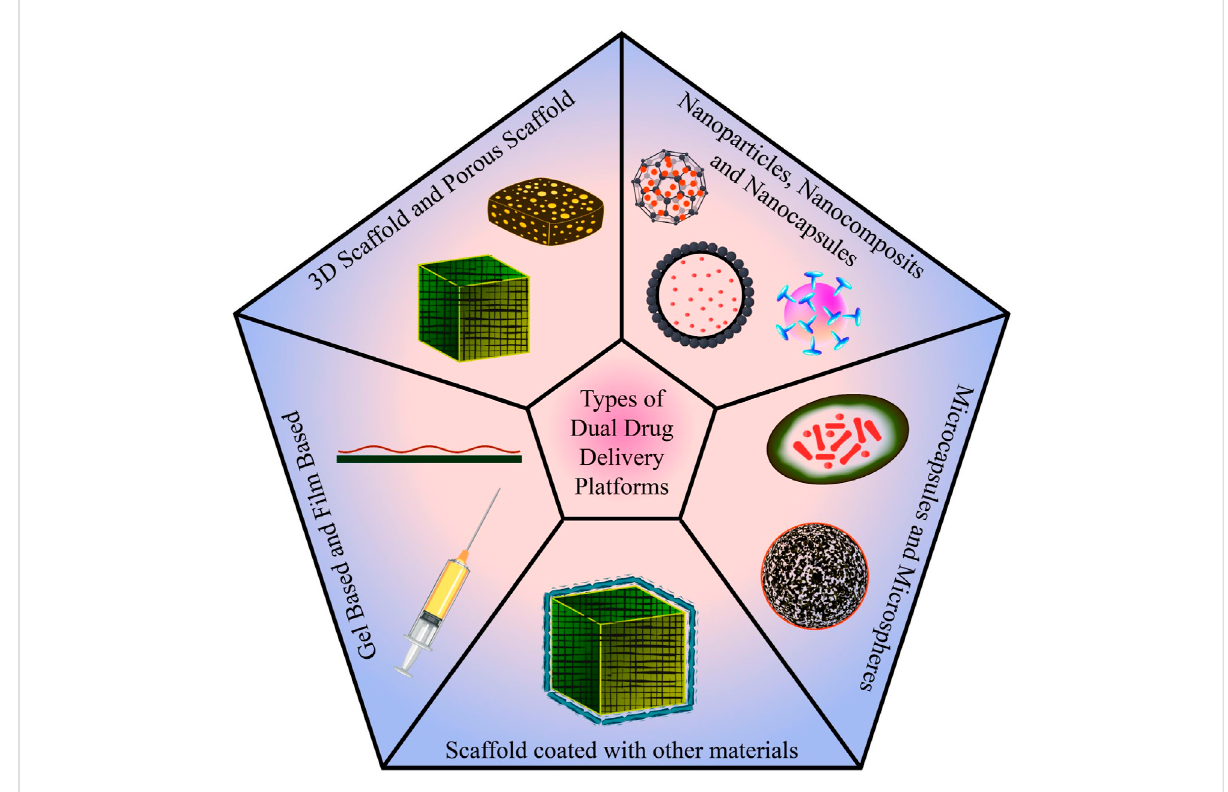
FIGURE 9 The fi ve classes of dual drug delivery